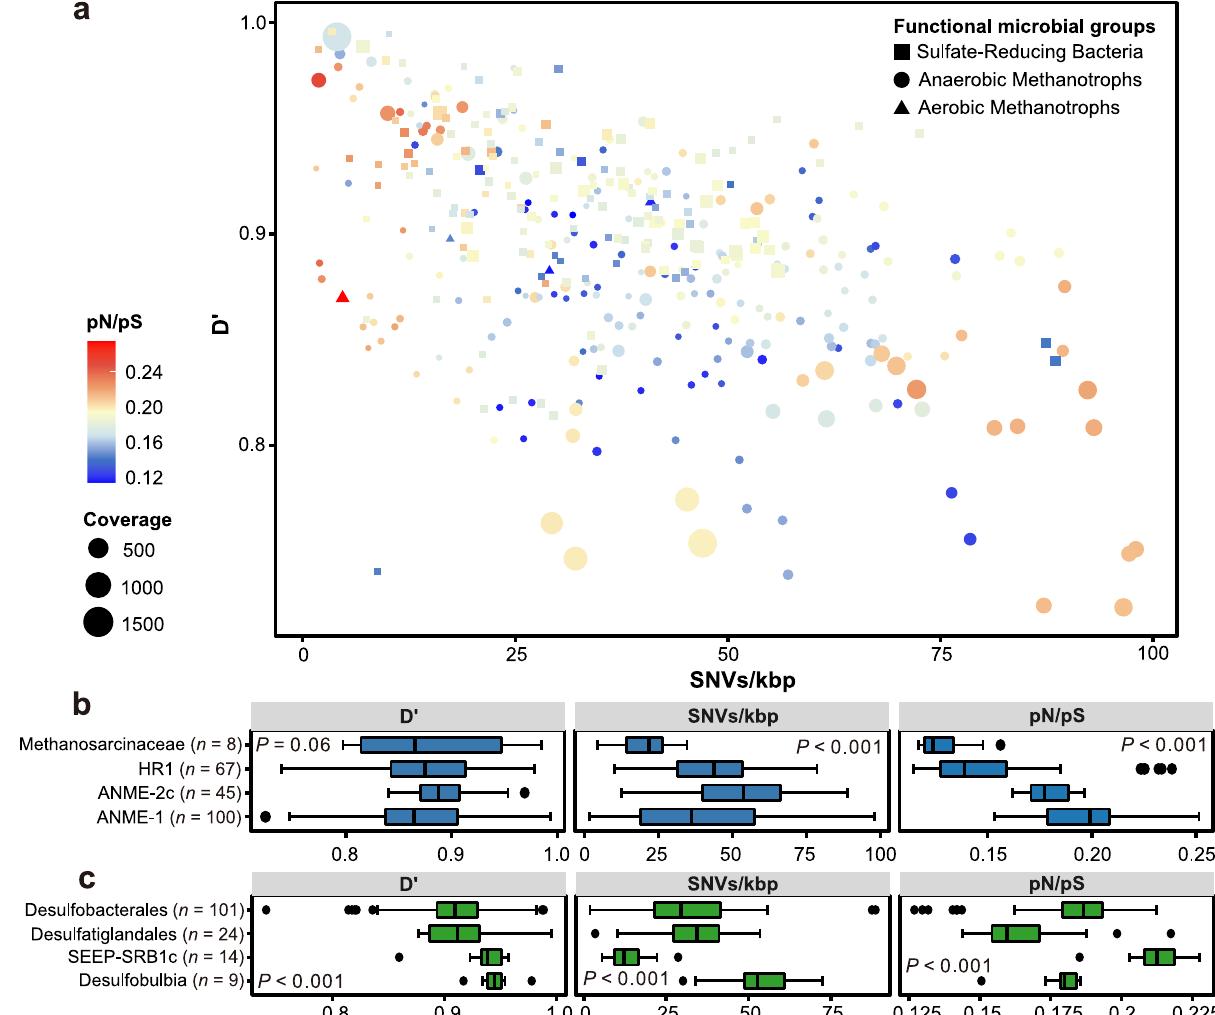
Fig. 3 | Genome-wide evolutionary metrics of three key functional microbial groups in cold seep sediments. a Relationships between SNV density (SNVs/kbp; x-axis), linkage disequilibrium (D ’ ; y-axis), the ratio of nonsynonymous to synon- ymous polymorphisms (pN/pS; symbol color), and genome coverage at the gen- ome level (symbol diameter). Each symbol represents one species-level microbial population, with shapes corresponding to MOB, ANME, or SRB guilds. b , c Comparison of SNV density, D ’ and pN/pS of sulfate-reducing bacteria and